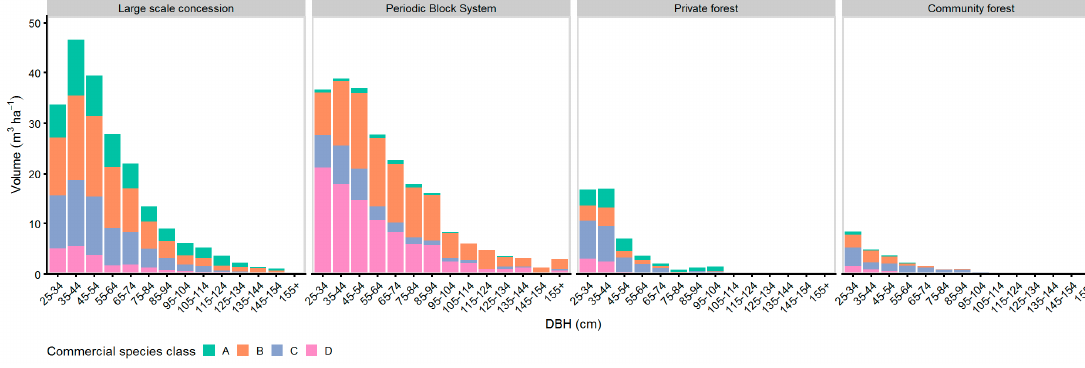
Figure 9. DBH-histogram of commercial species classes of trees with LG 1 & 2 selected for harvest.